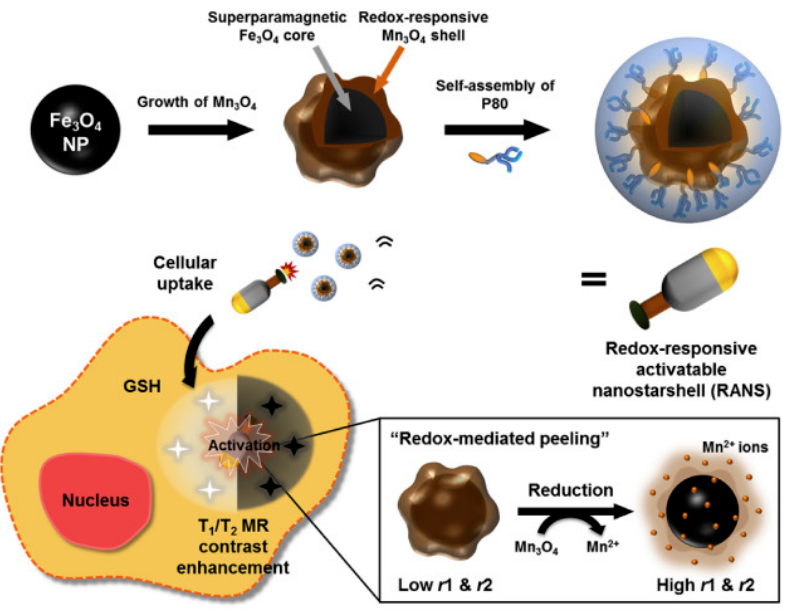
Figure 1 . Redox-responsive activatable nanostarshell (RANS). GSH: Glutathione. Reprinted (adapted) with permission from [34]—Published by Elsevier .